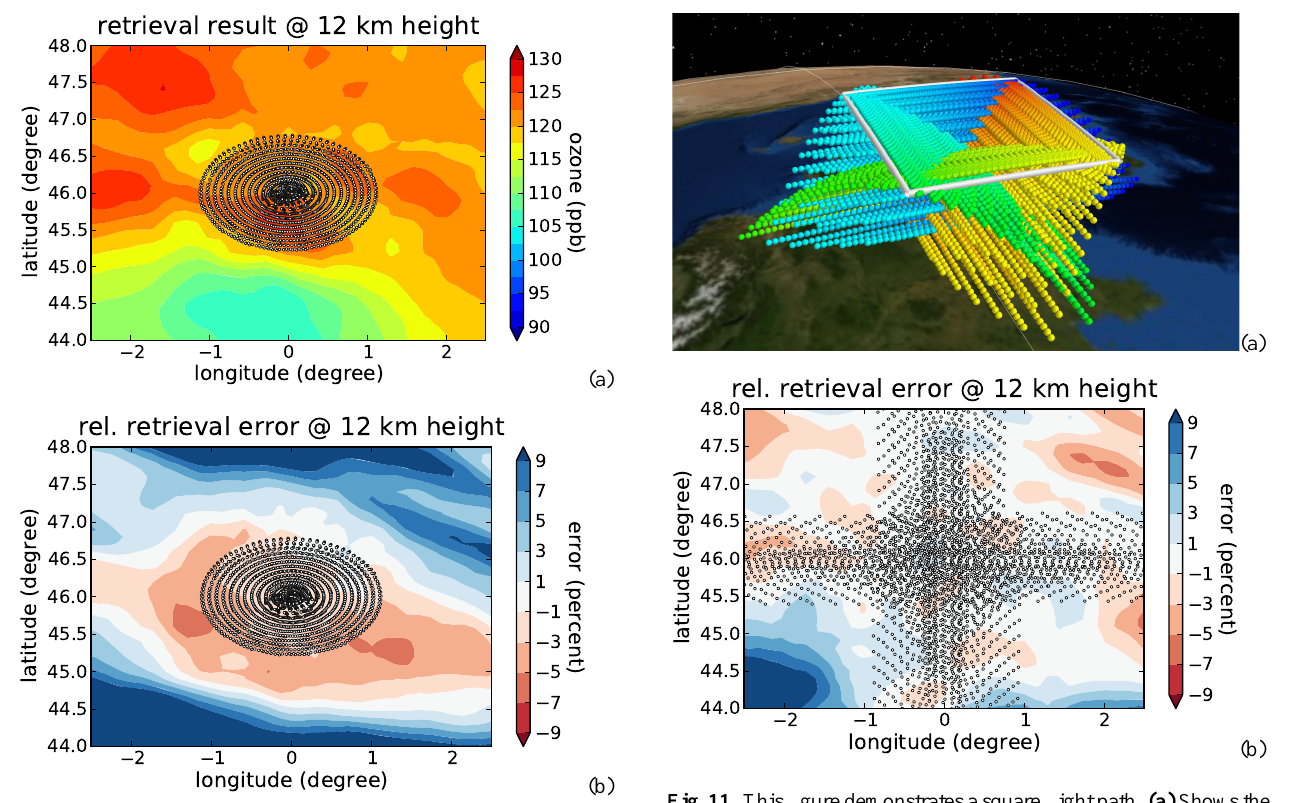
Fig. 11. This figure demonstrates a square flight path. (a) Shows the location of the tangents of the measurements as color-coded spheres (red being the first measurements, blue the last ones) and the flight- track as white tube. (b) Shows the relative error of the retrieval result at 12km